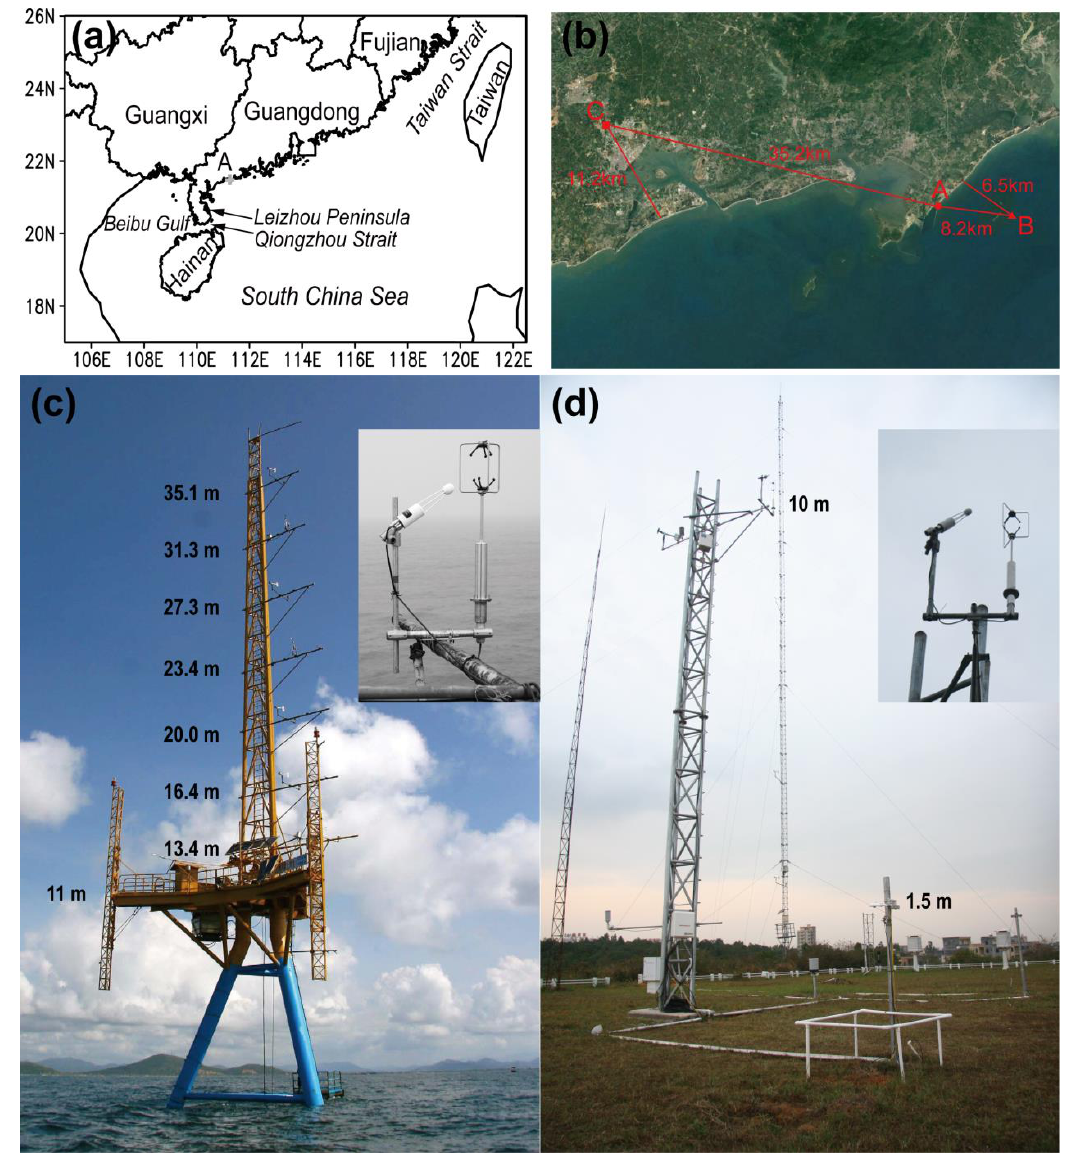
Figure 1. Observational site locations and close views. ( a ) Observational site A location (gray cross) on the southern China coast. ( b ) The coastal site A is the Marine Meteorological Science Experiment Base (MMSEB) (21.45° N, 111.32° E, 7.0 m MSL), the oversea site B is the Integrated Observation Platform for Marine Meteorology (IOPMM) (21.44° N, 111.39° E, operated by MMSEB), and the inland site C is the Dianbai National Climate Observatory (DNCO) (21.55° N, 110.99° E, 31.6 m MSL). Distances from different locations and from coastal lines (from Google Earth). ( c ) Close view of oversea site B (IOPMM); the upper-right corner of the image is the mounting position of the Gill Windmaster Pro and Li-cor 7500A instruments at the 23.4 m level (main photo courtesy of Weikang Mao on 27 June 2014). ( d ) Close view of inland site C (DNCO); the upper-right corner of the image is the mounting position of the Gill Windmaster Pro and Li-cor 7500A instruments at the 10 m level (main photo courtesy of Weikang Mao on 20 January 2017).